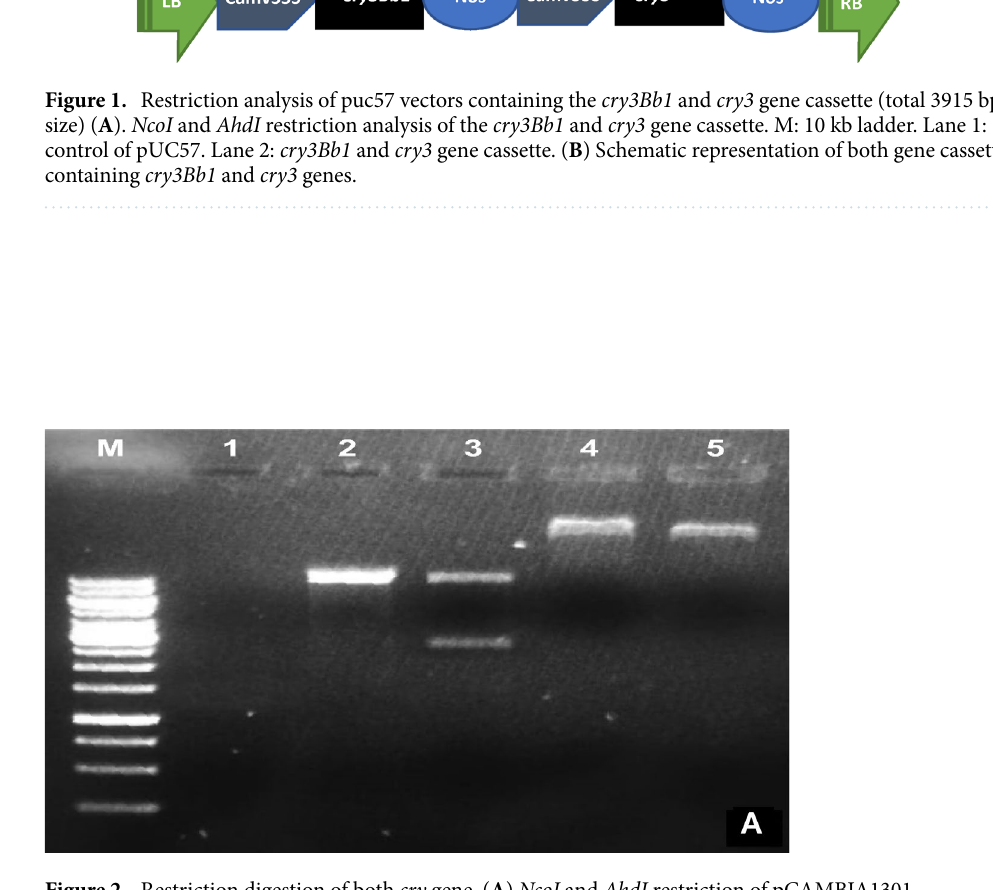
Figure 2. Restriction digestion of both cry gene. ( A ) NcoI and AhdI restriction of pCAMBIA1301 vector containing cry genes cassette; M: 10 kb molecular weight marker, Lanes 1: shows blank, Lane 2: shows pCAMBIA1301, Lane 3: shows ligation without ligase, Lane 4, 5: shows ligation of cry genes with pCAMBIA1301. ( B ) PCR amplification of both cry genes. M: 10 kb molecular weight marker, Lanes 1, 2: show cry3Bb1 gene (459 bp), Lane 3, 5: show cry3 gene (562 bp), Lane 4: shows a